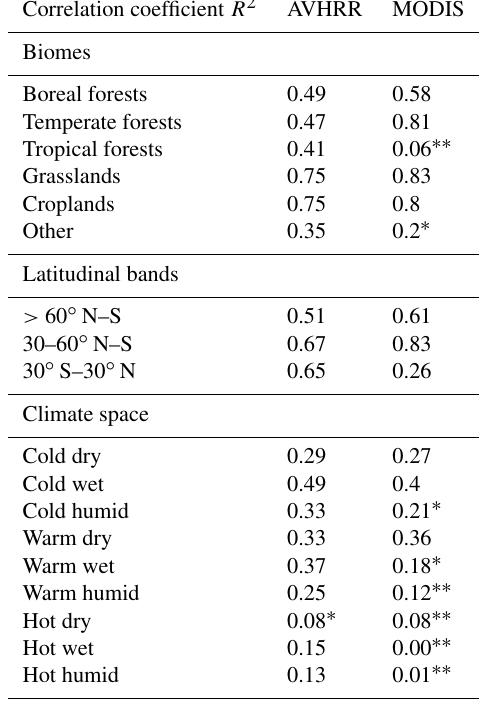
Table 1. Coefficients of determination ( R 2 ) of LAI max sensitivity to CO 2 for different large-scale aggregated regions. Data are from two optical remote sensors of different time length, AVHRR (1982– 2016) and MODIS (2000–2016). Asterisks denote nonsignificant values: ∗∗ p > 0 . 1; ∗ p > 0 .